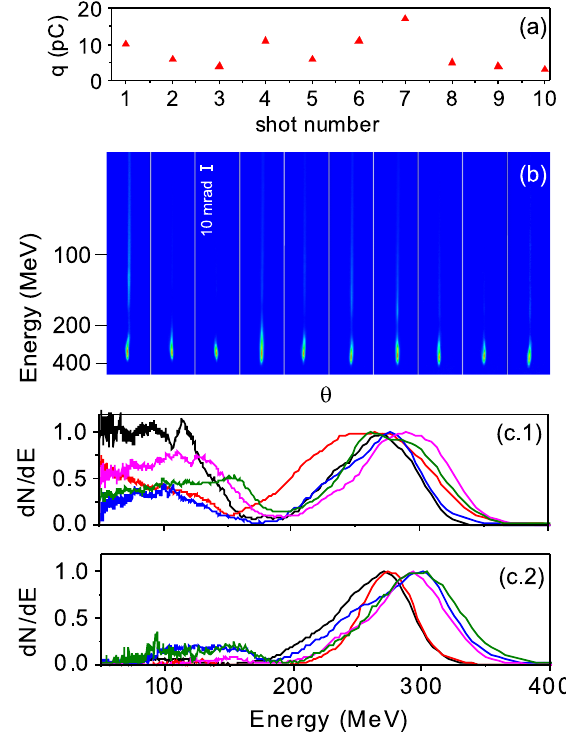
FIG. 6. LANEX images of magnetically dispersed beams [panel (b)] and corresponding spectral lineouts [panels (c.1) and (c.2)] for ten consecutive shots taken at n e ¼ 6 (cid:2) 10 18 cm (cid:3) 3 and P ¼ 43 TW ; the color scale is normalized for each shot. Panel (a) shows the integrated charge, taking into account background noise on the detector. All beams have a QME feature with the energy (cid:5) 300 MeV , carrying a few pC charge. Shots no. 2, 3, and 8–10 show no significant electron signal below 200 MeV [lineouts in panel (c.2)]. Presence of the background in other shots [lineouts in panel (c.1)] raises the charge to 10–20